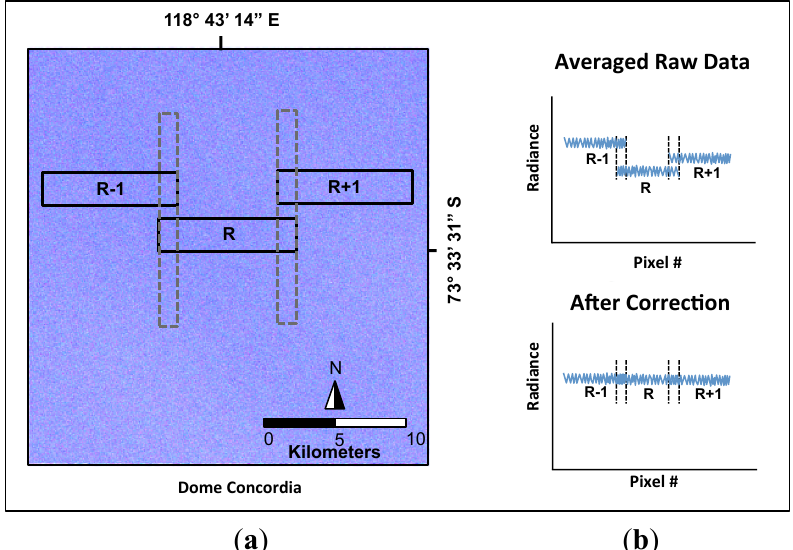
Figure 9. Illustration of how overlap region can be exploited to flat-field between